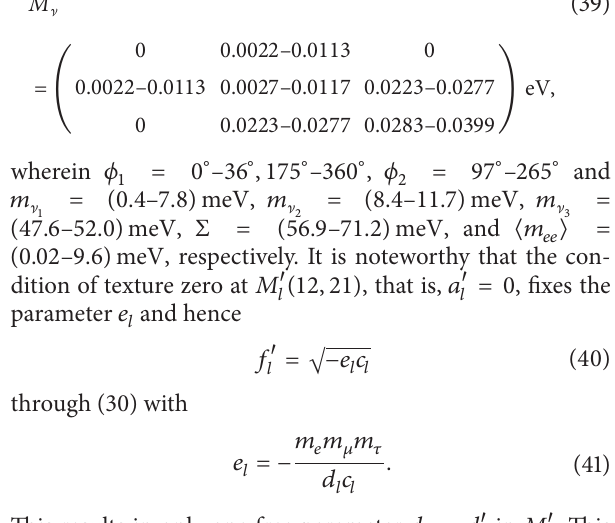
Figure 6: 𝛿 𝑙 versus 𝑒 𝑙 for Case A.